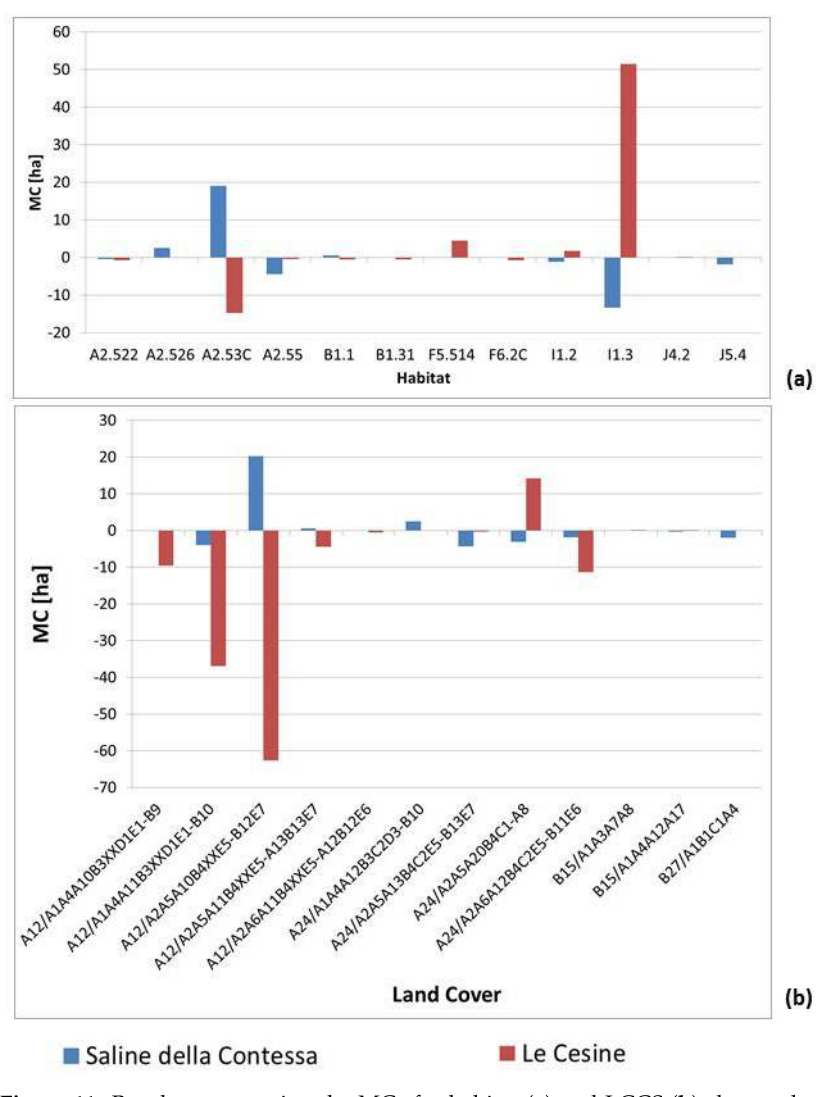
Figure 11. Barplots comparing the MCs for habitat ( a ) and LCCS ( b ) classes shared between the two two sites.